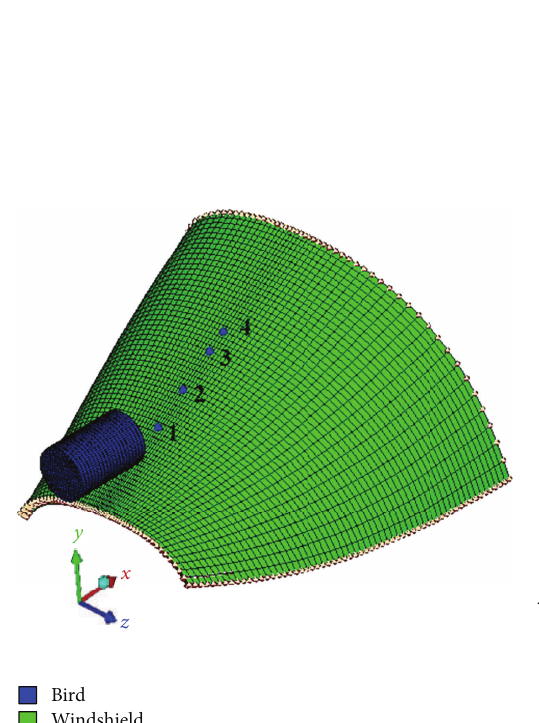
From analysis, the Hugoniot pressure was predicted to have a maximum value of 102.5 MPa and the stagnation pressure is 6.5 MPa, giving normalized values of 15.7 and 1, respectively. The analytical values of Hugoniot pressure and stagnation pressure were calculated as 86.3 MPa and 6 MPa, which after normalizing gives 14.3 and 1,